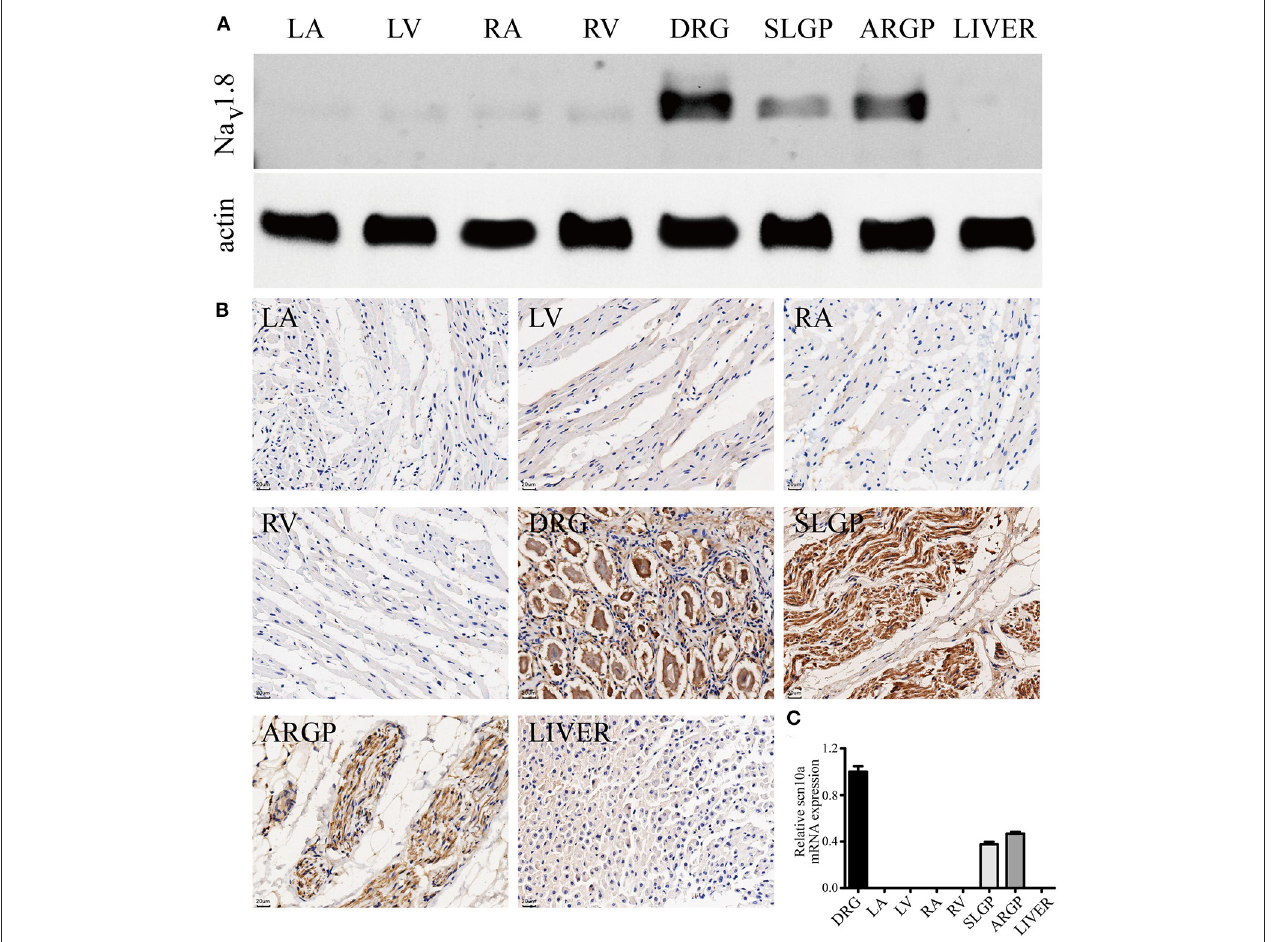
FIGURE 5 | Scn10a /Na V 1.8 expression in canine GPs and the myocardium. (A) Typical western blots for Na V 1.8, n = 4. (B) Typical immunohistochemistry-stained sections for Na V 1.8, scale bar = 20 µ m, n = 4. The results confirmed the presence of Na V 1.8 proteins in canine GPs but rarely expression in atria and ventricles. (C) Scn10a transcripts were readily detected in both superior left ganglionated plexi (SLGP) and anterior right ganglionated plexi (ARGP) but were not detected in right atrium (RA), left atrium (LA), left ventricle (LV), and right ventricle (RV) by qPCR. n = 4. Dorsal root ganglia (DRG) was used as the positive control and the liver was used as the negative control.